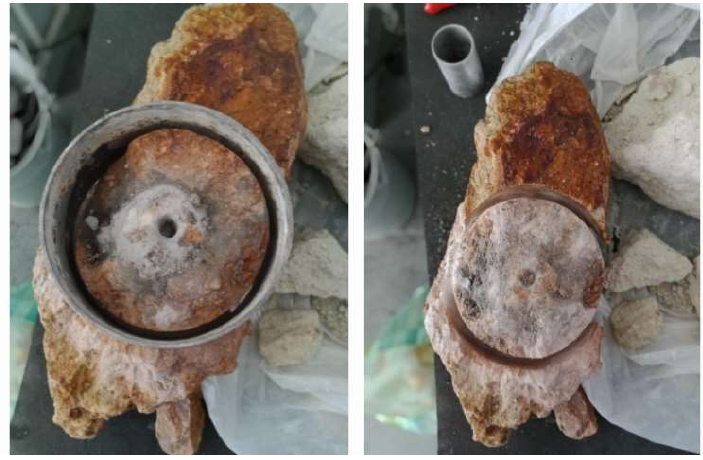
Figure 6. Rock sample from Hallaç Complex, which could not be cut to be used for impedance tube testing.